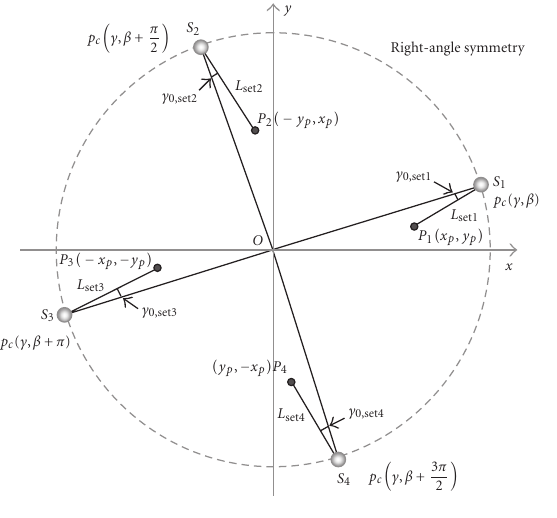
Figure 6: Complement symmetry. Two pairs of source and pixel positions share essentially the same L and y 0